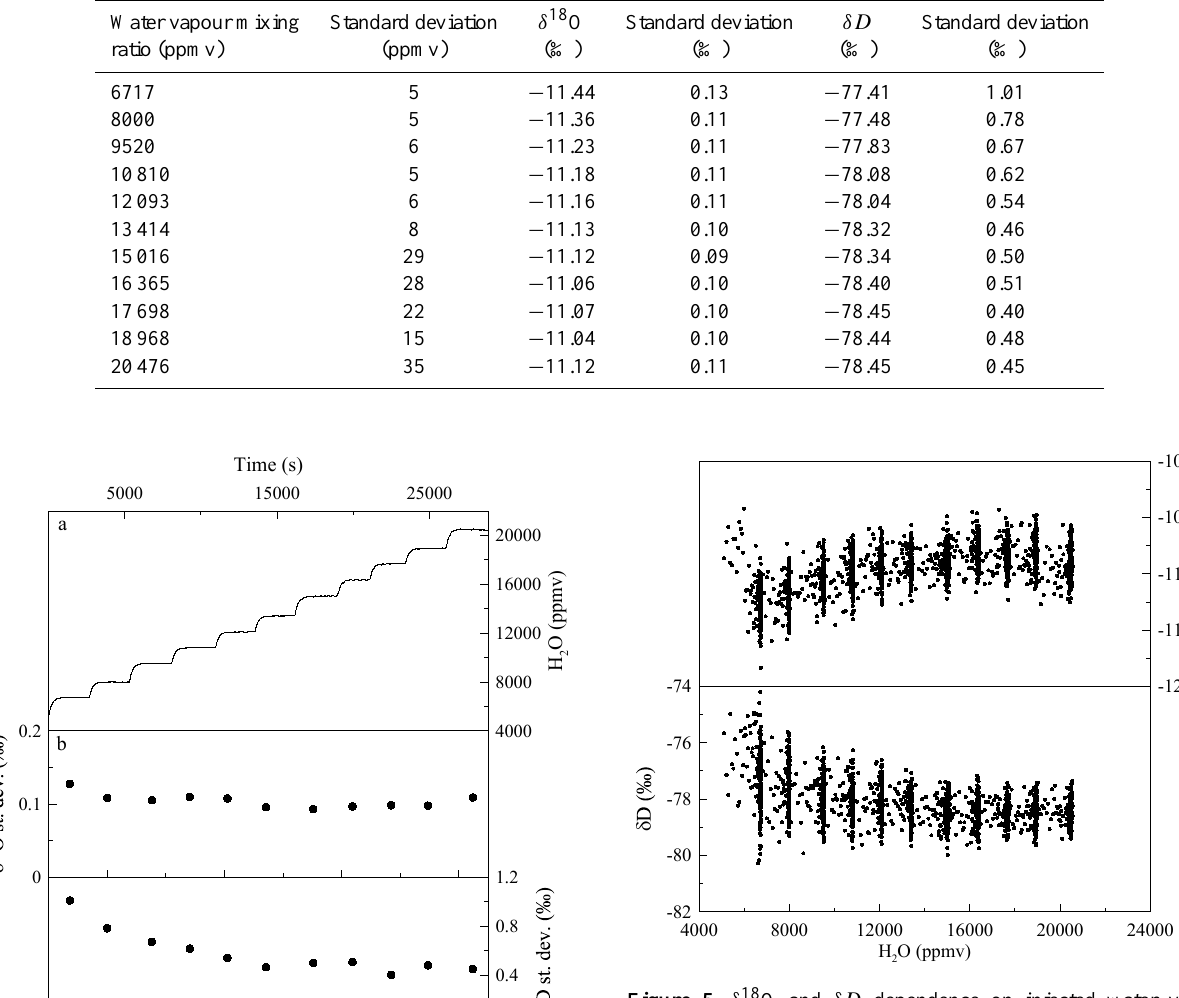
Figure 5. δ 18 O and δD dependence on injected water vapour amounts presented in Fig